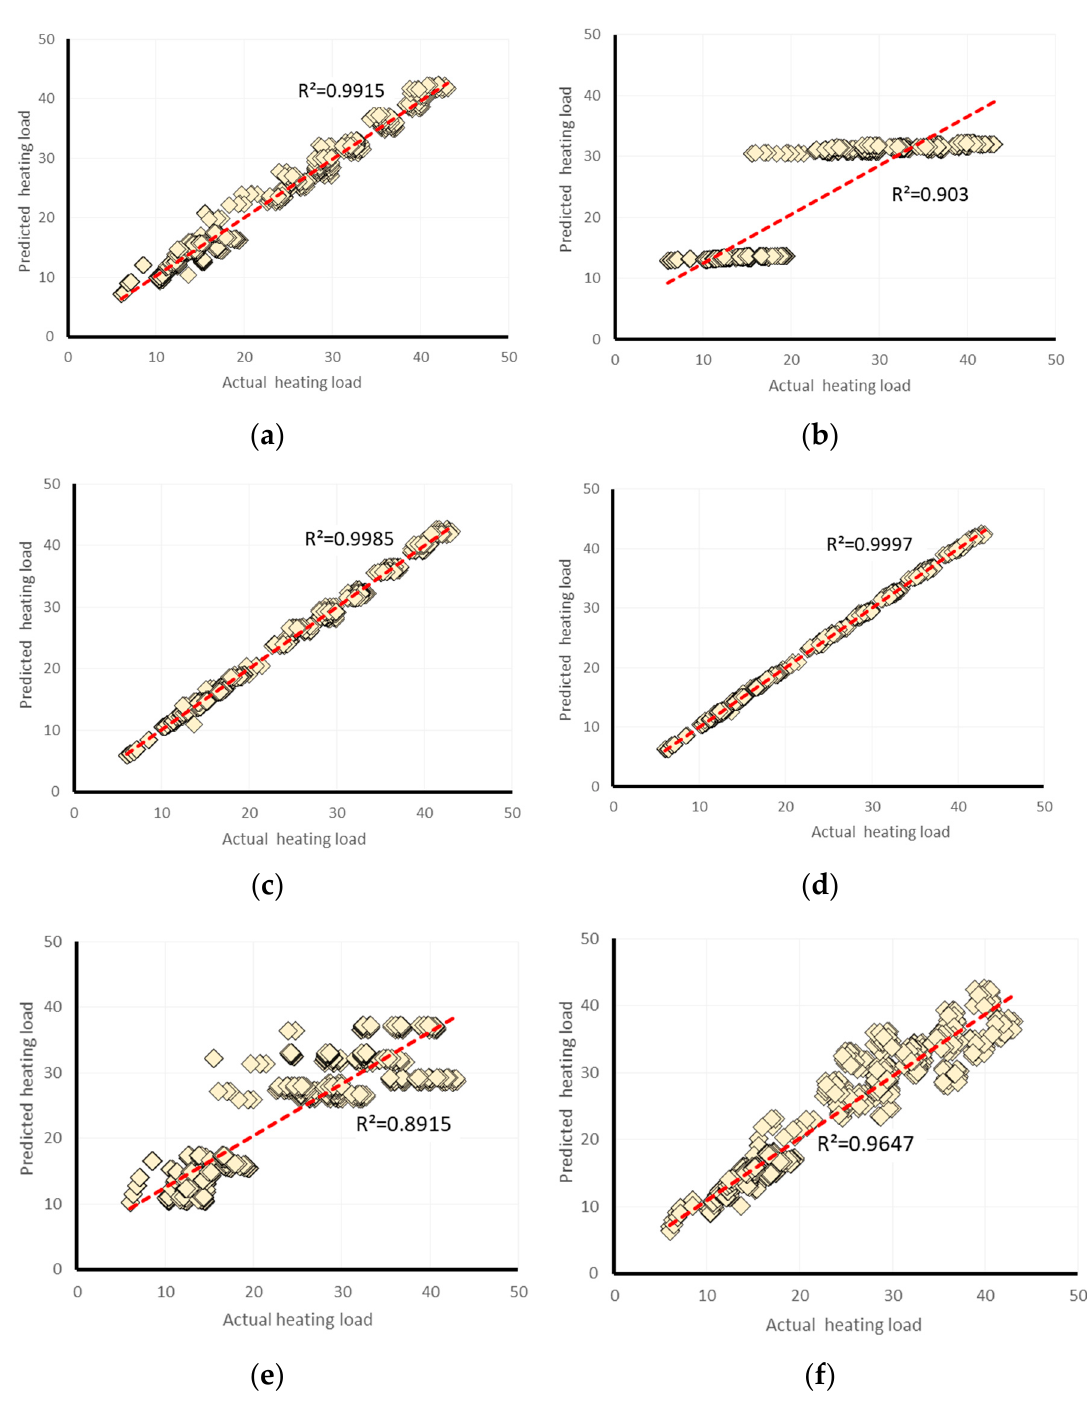
Figure 10 . The network outputs for the training dataset. ( a ) MLPr; ( b ) LLWL; ( c ) AMT; ( d ) RF; ( e ) ENet; ( f ) RBFr.